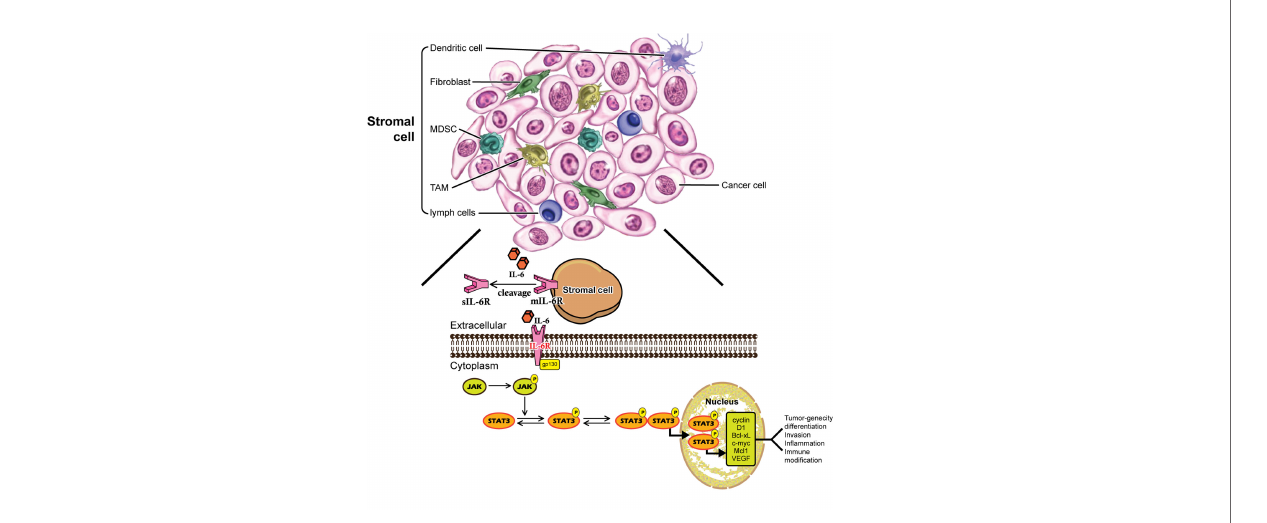
FIGURE 1 | The interaction network of IL-6 and breast cancer cells/stromal cells.